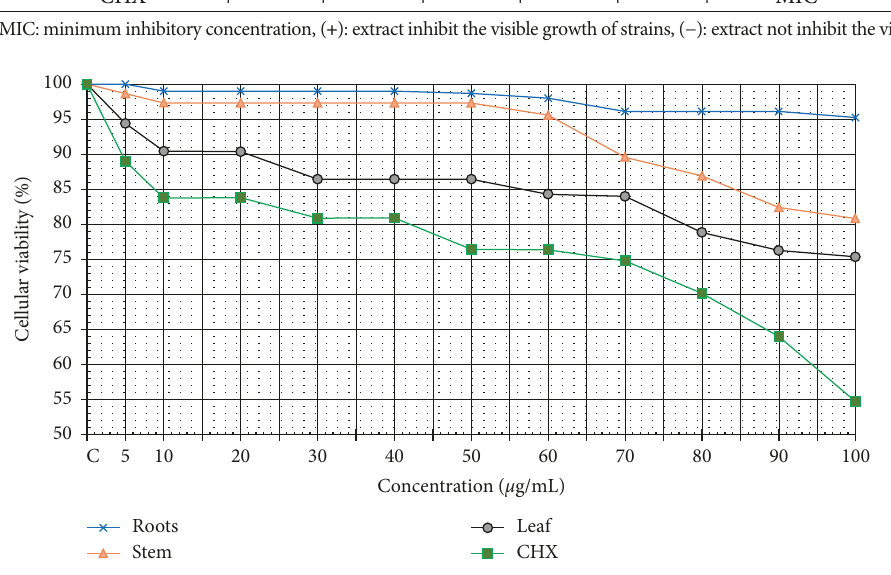
Figure 1: Cellular viability evaluation of the methanolic extracts of Pelargonium peltatum using MCDK cell line.